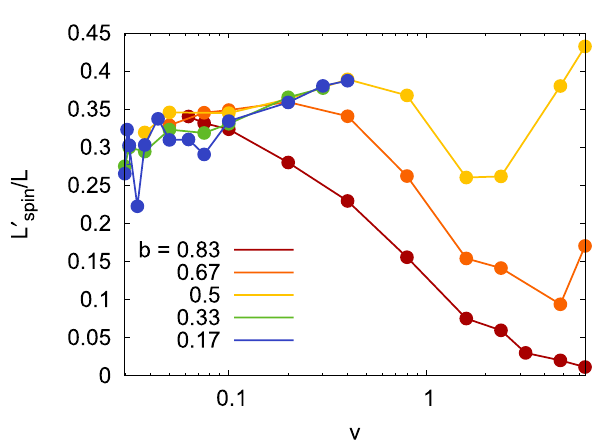
Figure 8. Relative spin momenta as a function of collision velocity v after collision for several impact parameters b . Data are only shown for bouncing collisions. Note the logarithmic abscissa